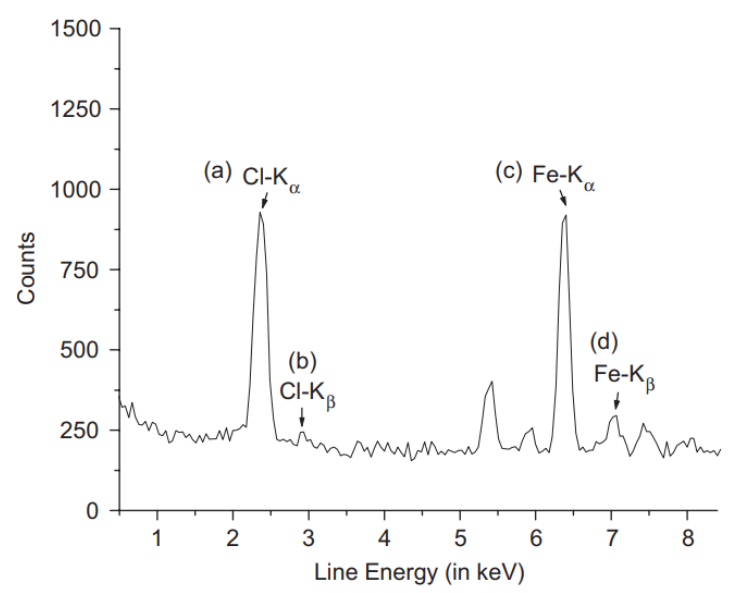
Figure 33. Detection of FeCl 3 in a polycarbonate membrane for hydrogen separation [142]. Table 11. XRF studies for membrane characterization.